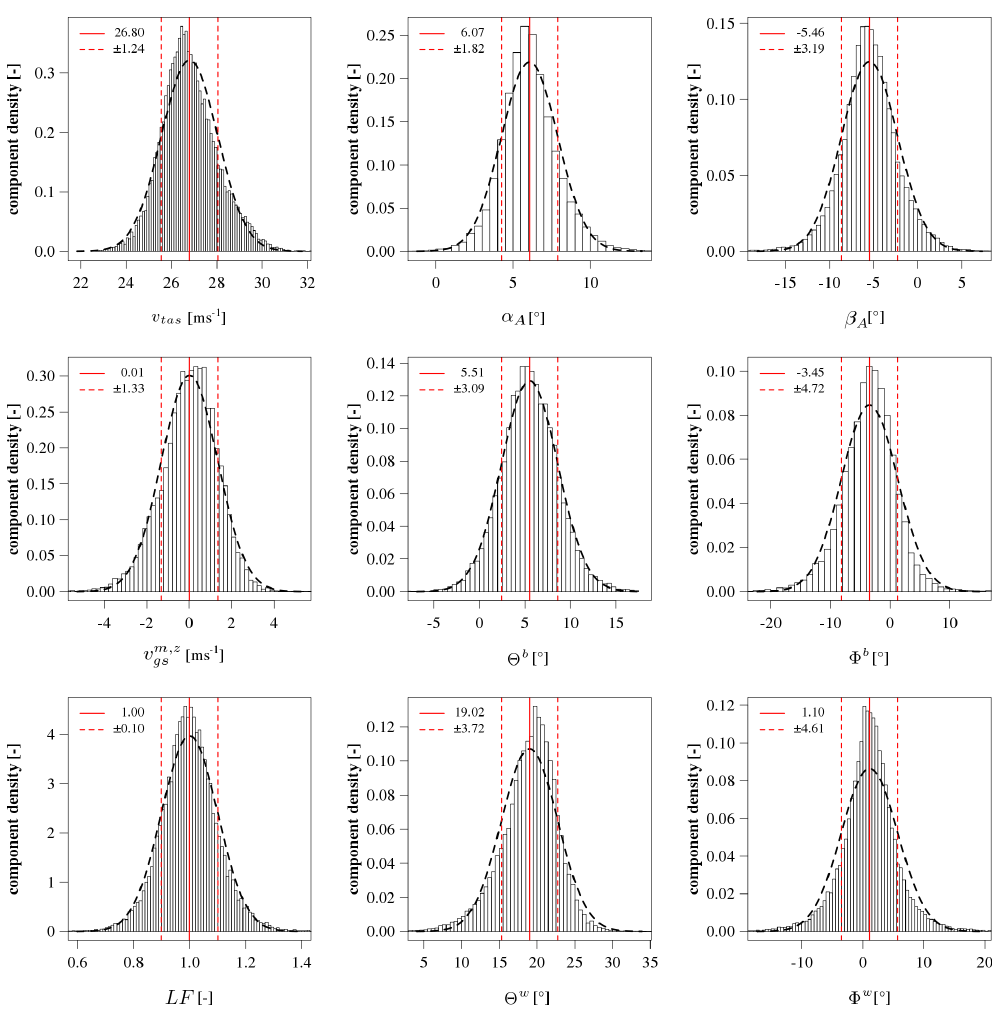
Fig. 4. Histograms of aircraft properties derived for the flight on 31 July 2009 (Table 3). Component density is scaled so that the histograms have a total area of one. Red vertical lines indicate distribution average (solid) and standard deviation (dashed). The black dashed bell curve displays a reference normal distribution: True airspeed ( v tas ), attack angle ( α A ), sideslip angle ( β A ), aircraft vertical velocity ( v m ,z gs ), trike pitch- ( Θ b ) and roll ( Φ b ) angles, loading factor ( LF , the ratio of lift- to weight force), as well as wing pitch- ( Θ w ) and roll ( Φ w ) angles.